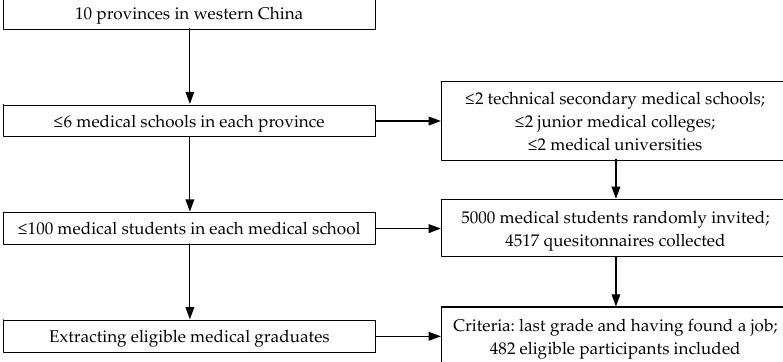
Figure 1. Study profile.